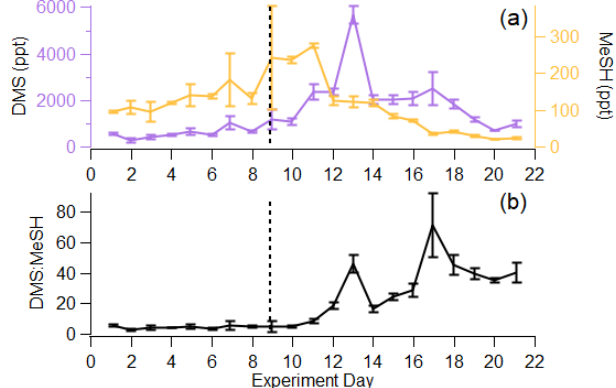
Figure 4. (a) Time series of DMS and MeSH in the ISV, where error bars indicate the standard deviation over the 1Hz measurements for the day. (b) Time series of DMS:MeSH, where error bars indicate the error propagation from (a) . Vertical line represents the addition of highly productive seawater and more